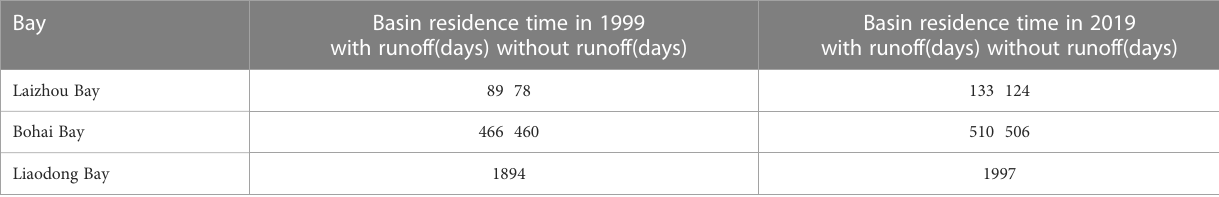
TABLE 2 Basin residence time of the BHS with/without runoff in 1999 and 2019. Bay Basin residence time in 1999 with runoff(days) without runoff(days)